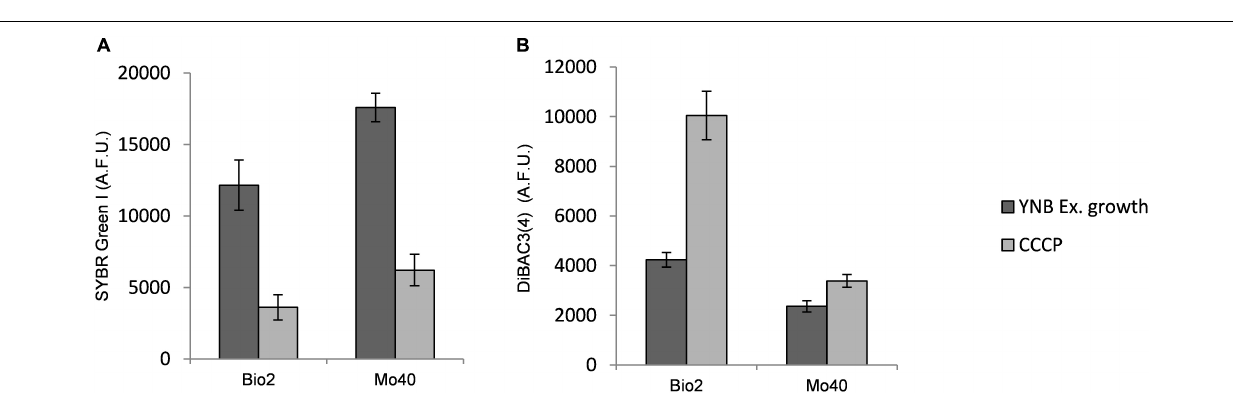
FIGURE 5 | Quantitative analysis of (A) SYBR Green I and (B) DiBAC4(3) fluorescences detected by FMC after exposure to carbonyl cyanide 3-chlorophenylhydrazone (CCCP), a protonophore inducing membrane depolarization. AFU, Arbitrary Fluorescence Units.